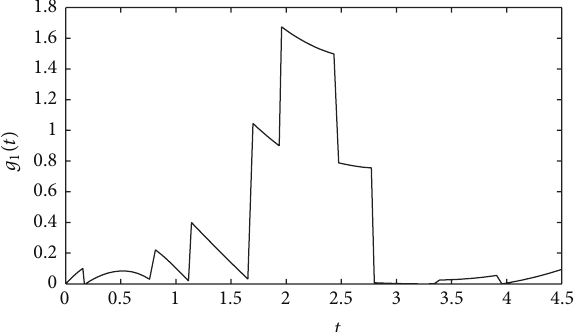
Figure 8: Constraint function under the optimal